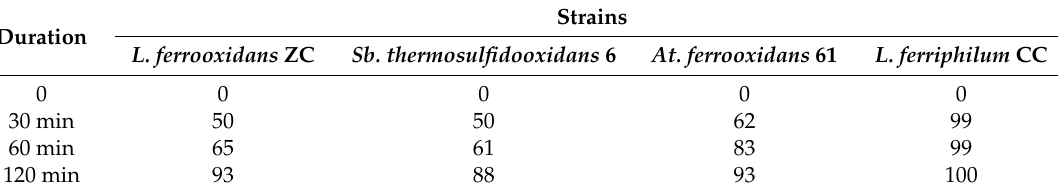
Table 2. Adhesion * of four leaching isolates to pyrite determined by direct counting or most probable number (MPN).